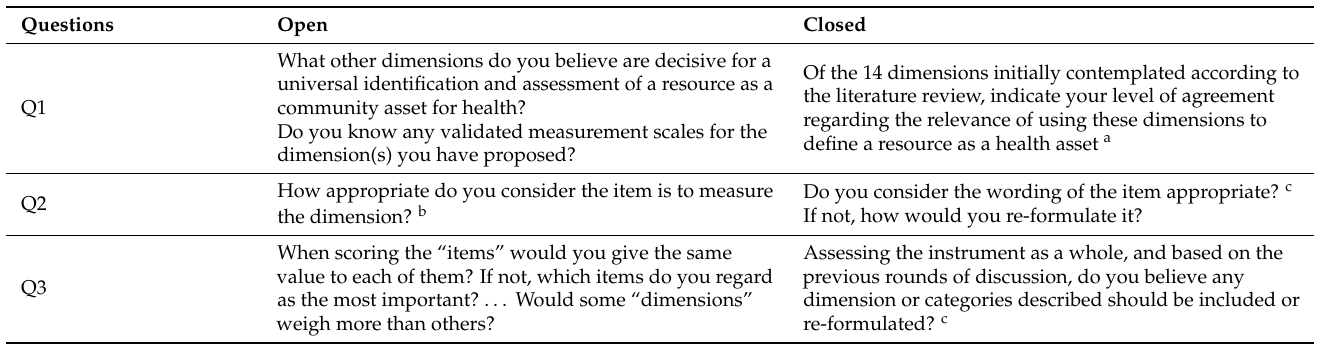
Table 2. Delphi panel questions